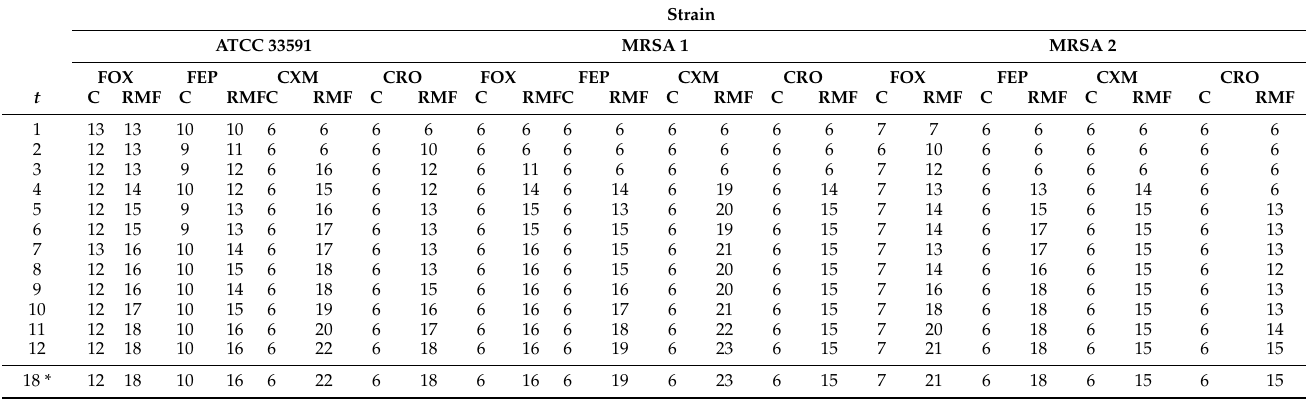
Table 2. Growth inhibition zones (mm) of MRSA strains around discs with β -lactam antibiotics depending on the RMF exposure (5 Hz)